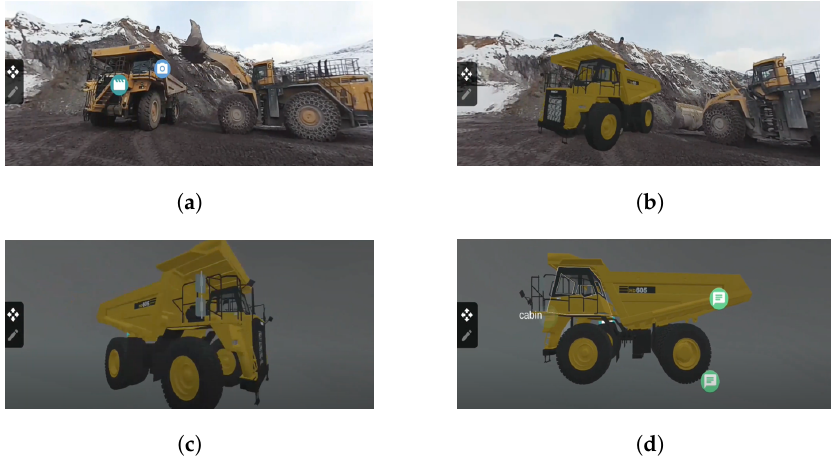
Figure 1. Transitioning from 2D video to the 3D virtual object: ( a ) 2D video. ( b ) Object replacement after detection and localization. ( c ) Object rotating in front of the user viewpoint. ( d ) Digital information contextualized with the vehicle model. The corresponding videos can be found here (https://youtu.be/E1fwuexrCo0, accessed on 20 April